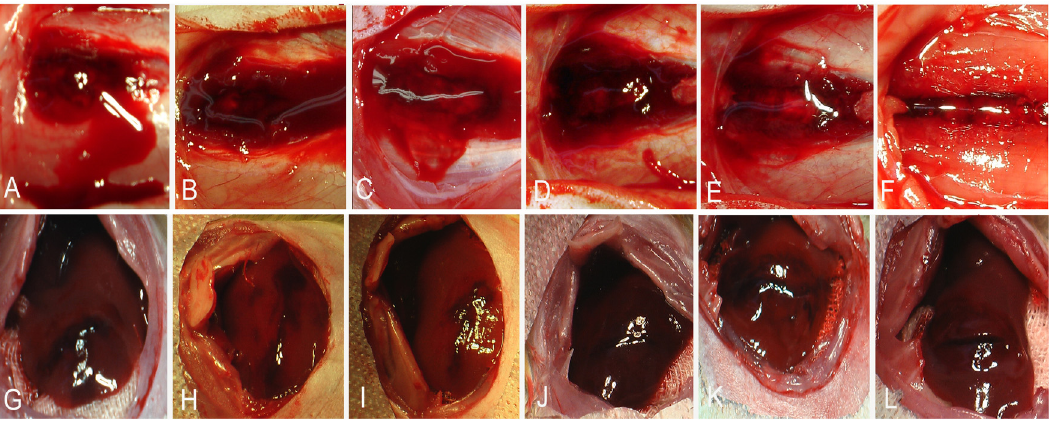
Figure 5. Hemostasis at ( A – F ) spinal cord transection and ( G – L ) rat liver transverse cut. RADA16-1 solution was applied at various points in time before and after sonication. The time required for complete cessation of bleeding was recorded: ( A , G ) 2 min, ( B , H ) 30 min, ( C , I ) 120 min, ( D , J ) 240 min, ( E , K ) 1440 min, and ( F , L ) pre-sonication. Note